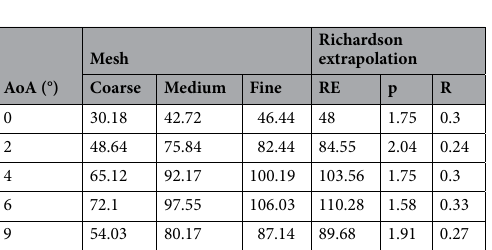
Figure 1. Structured mesh generated around the airfoil: ( a ) general view; ( b ) detailed view.